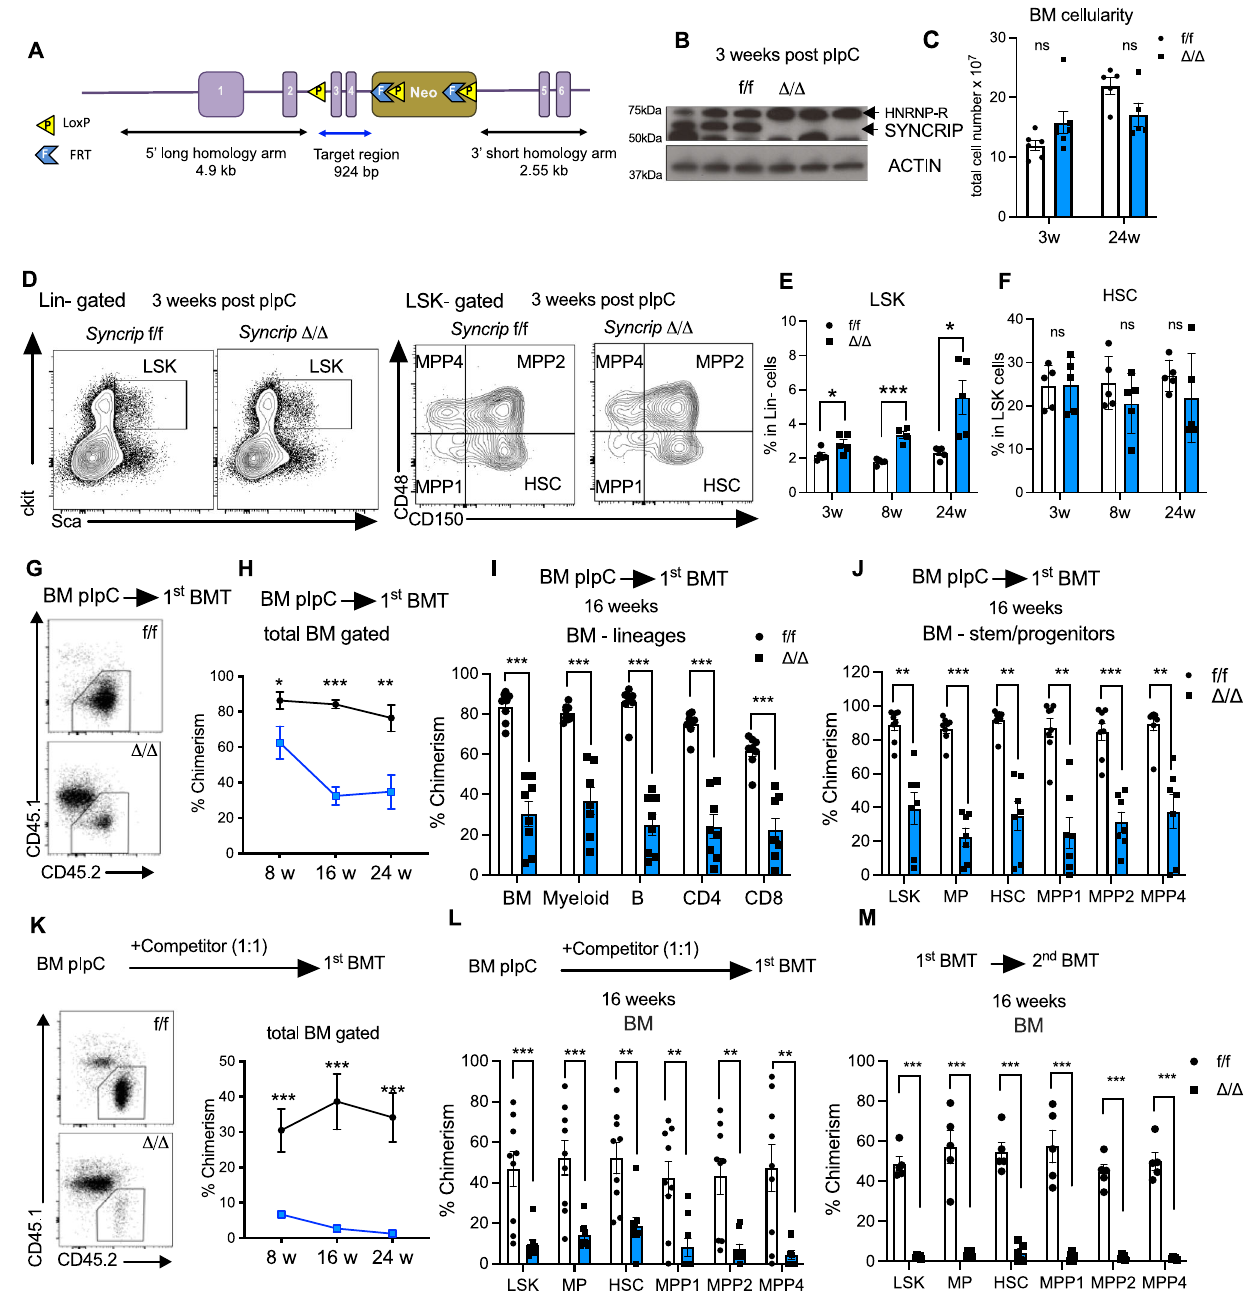
Fig. 1 |SYNCRIPisdispensableforsteady-statehematopoiesisbut requiredfor long-term HSC self-renewal. A Targeting strategy to create Syncrip conditional knockout mouse (cKO). B Immunoblots showing SYNCRIP KO in bone marrow of Syncrip Δ / Δ mice 3 weeks post pIpC injections. ACTIN as loading control. C Bone marrow (BM) cellularity Syncrip f/f ( n =6) and Syncrip Δ / Δ ( n =5) mice at 3- and 24 weeks post pIpC. D Representative fl ow analysis of stem/progenitor compart- ments Syncrip f/f and Syncrip Δ / Δ mice3weekspostpIpC.LSK(Lin-Sca+ckit+);HSC – hematopoieticstemcell(LSKCD48-CD150+);MPP-multipotent-progenitor;MPP1- LSK CD48-CD150-; MPP2-LSK CD48+CD150+; MPP4-LSK CD48+CD150-.